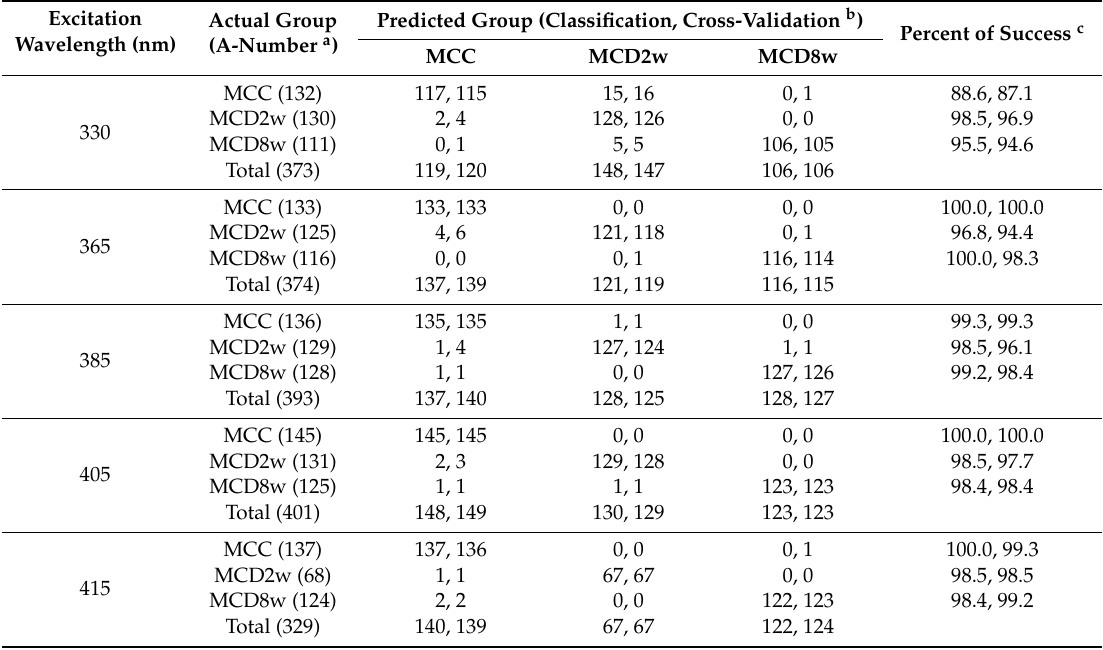
Table 2. Confusion matrix of the quadratic discriminant analysis (QDA) classification and cross validation models performed on the first six principal components of spectral data gathered with di ff erent excitation lights on the three possible liver groups—MCC, MCD2w, and MCD8w.